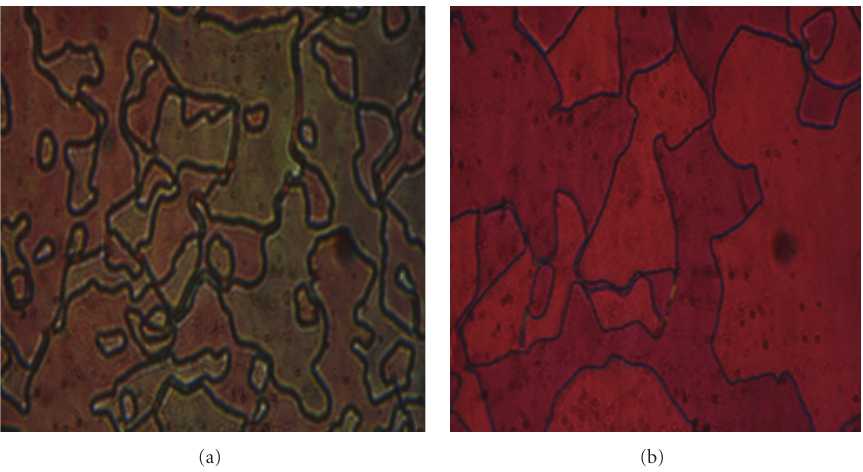
Figure 3: Nematic textures of (a) 4OBA at temperature 161 ◦ C and (b) 6OBA at temperature 150 ◦ C.